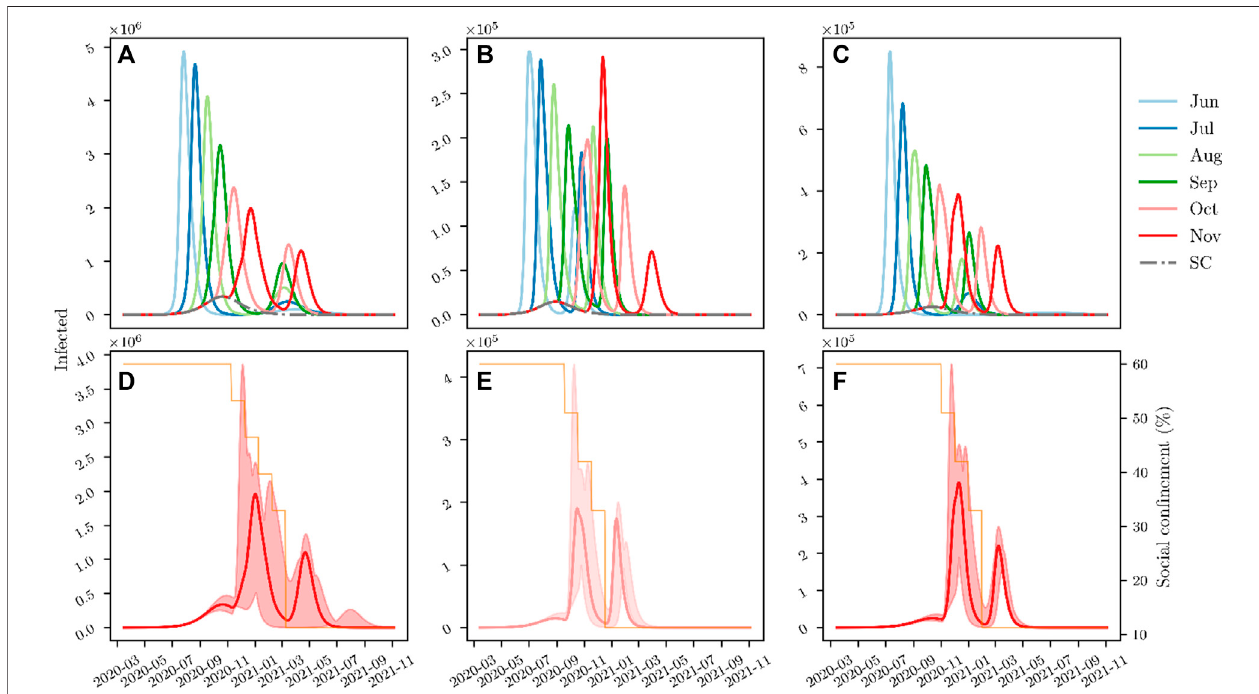
FIGURE 5 | Scenario 3: Gradual lifting Con fi nement on June 1, 2020. Panels (A) shows a step-wize social con fi nement lifting at different time points for the whole country; (B) CMX, and; (C) MEX, respectively. Panels (D) underlined the best scenario for con fi nement lifting in the whole country; (E) CMX, and; (F) MEX, respectively. Thisconsistsonkeepingincon fi nementafractionofthepopulationequivalenttothesizeoftheelderly,whileafractionrepresentingthecon fi nedworkingforceofMexico (about 27%) returns to activity in four parts (three steps for CMX and MEX), each one in consecutive months, while a fraction assuming the students would come back to school one month after the working group.